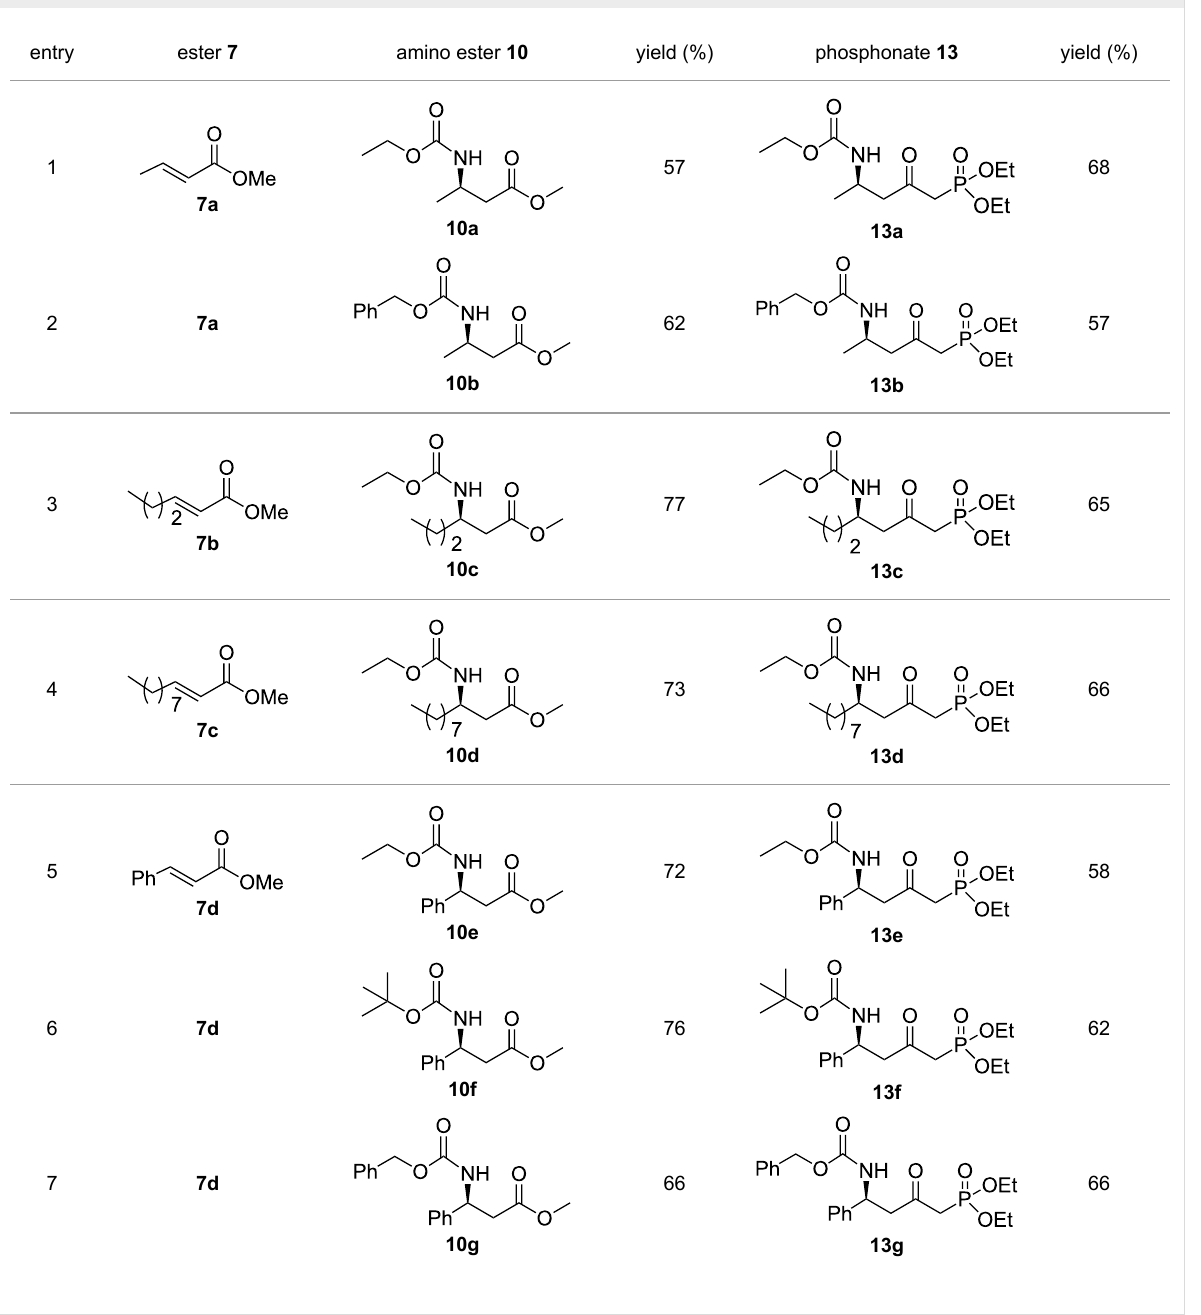
Table 1: Formation of the ketophosphonates 13